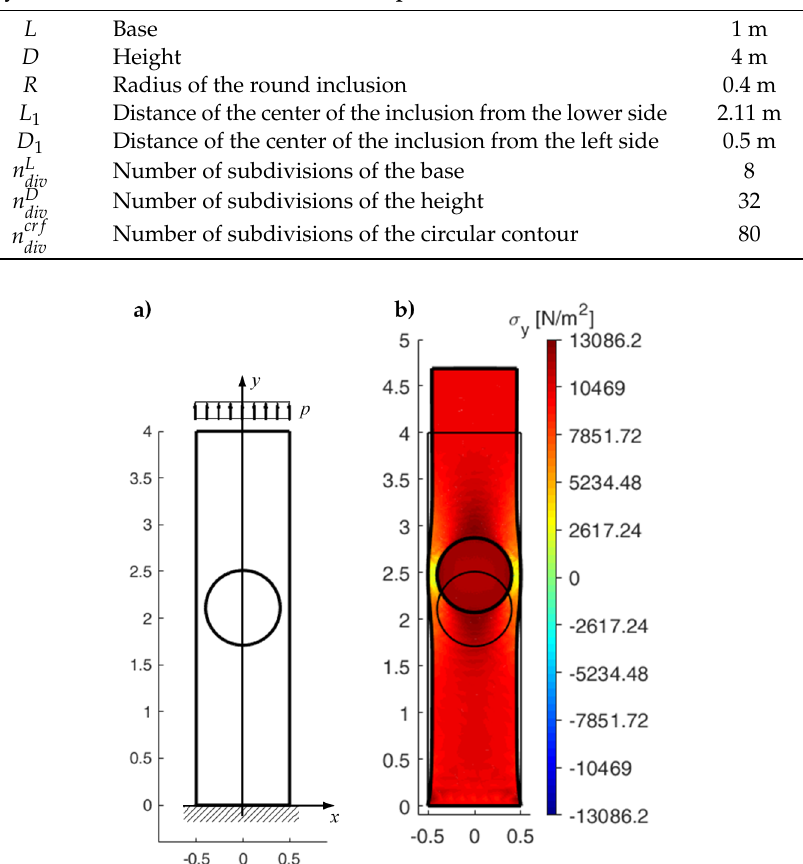
Figure 29. DECM static analysis for the 1 × 1 array generated by the discrete element with the geometric characteristics defined in Table 2. ( a ) Array geometry and loading conditions. ( b ) normal stresses σ y plotted on the deformed configuration (Thin line: undeformed configuration. Thick line: deformed configuration. Amplification factor of the displacements: k = 500).